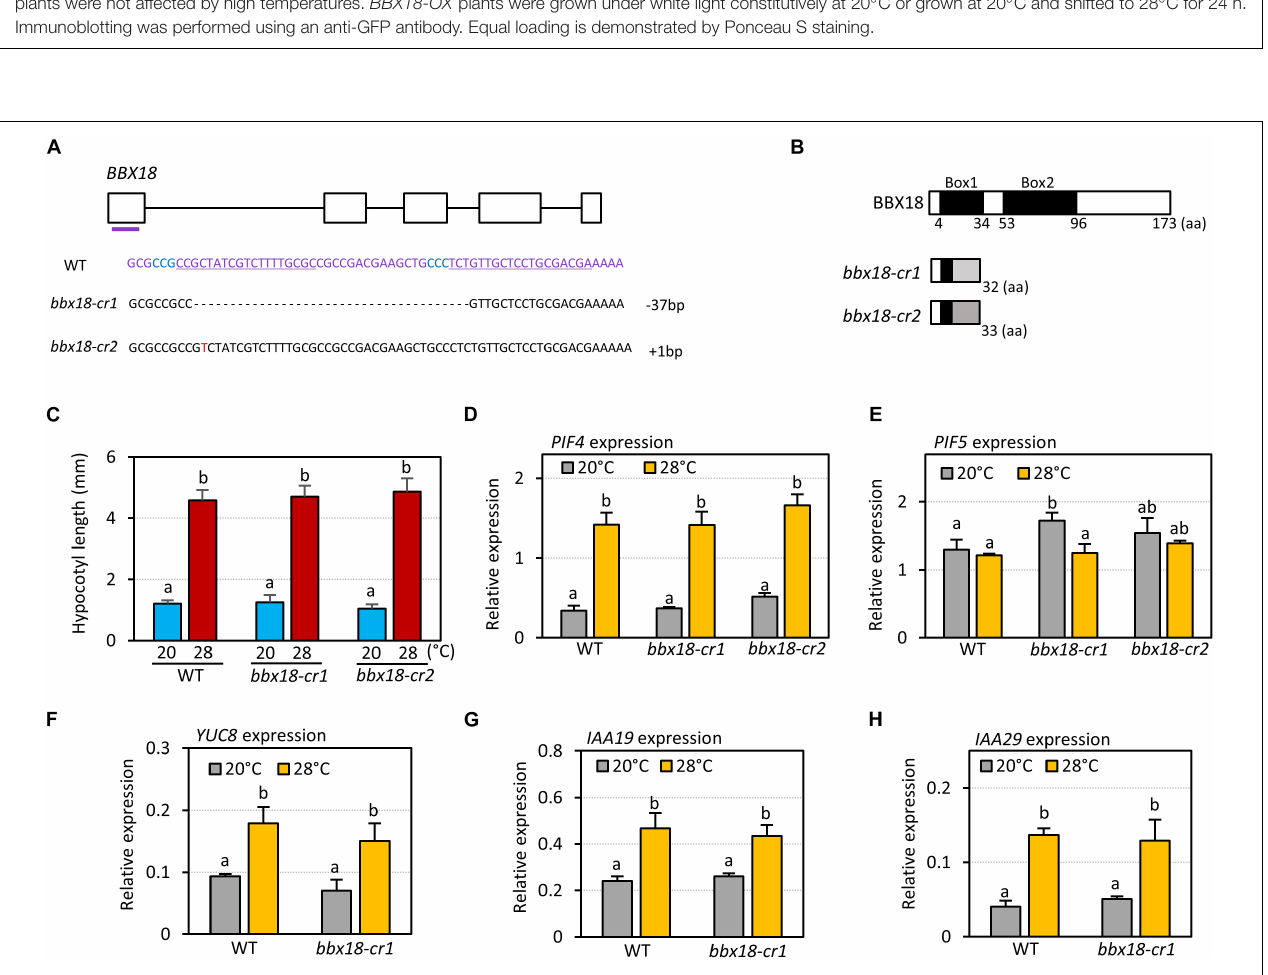
FIGURE 2 | bbx18 loss-of-function mutants show normal thermoresponsive hypocotyl growth. (A) Sequence analysis of CRISPR/Cas9-generated bbx18 mutations. The gRNA target sequences are depicted by the underlined sequences. The PAM site is in blue. (B) Predicted truncated BBX18 proteins in the bbx18-cr1 and bbx18-cr2 mutants. aa, amino acids. (C) Hypocotyl lengths of WT, bbx18-cr1 , and bbx18-cr2 seedlings grown under continuous white light at 20 ◦ C for 7 days (20 ◦ C) or 20 ◦ C for 4 days followed by 28 ◦ C for 3 days (28 ◦ C). Letters above the bars indicate significant differences based on a one-way ANOVA and Tukey’s test ( P < 0.05). qRT–PCR analyses to check the expression of PIF4 (D) , PIF5 (E) , YUC8 (F) , IAA19 (G) , and IAA29 (H) . WT and bbx18 mutants were grown in 12 h light/12 h dark cycles (12L:12D) at 20 ◦ C for 4 days. On the 5th day, the plants were shifted to continuous white light and exposed to a high temperature of 28 ◦ C